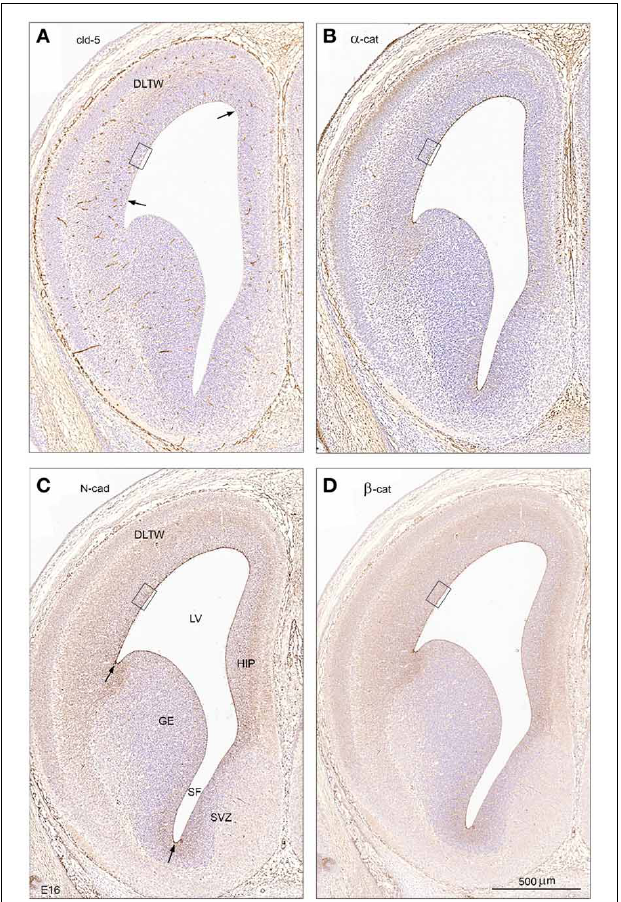
FIGURE 6 | Tight and adherens junctional proteins in embryonic mouse brain. An overall view of tight and adherens junctional proteins in the ventricular zone of early mouse CSF-brain interface at low magnification in coronal sections of E16 brain showing immunostaining for claudin-5 (A) , α -catenin (B) , N-cadherin (C) , and β –catenin (D) . Note the differences in distribution of immunopositive staining between different regions of the surface of the ventricular zone with strongest staining of the dorsolateral telencephalic wall (DLTW) and a weak or lacking immunoreactivity of the ganglionic eminence (GE). Arrows in A point to the border of faint claudin-5 reactivity of the ventricular surface of the dorsolateral wall, and in (C) to the increased staining of the dorsolateral and ventral borders of the ganglionic eminence. The boxed areas in (A–D) are shown in higher magnification in Figure 7 . HIP, hippocampus; LV, lateral ventricle; SF, septal fork of the lateral ventricle; SVZ, septal ventricular zone. (A–D) Same magnification, scale bar 500 μ